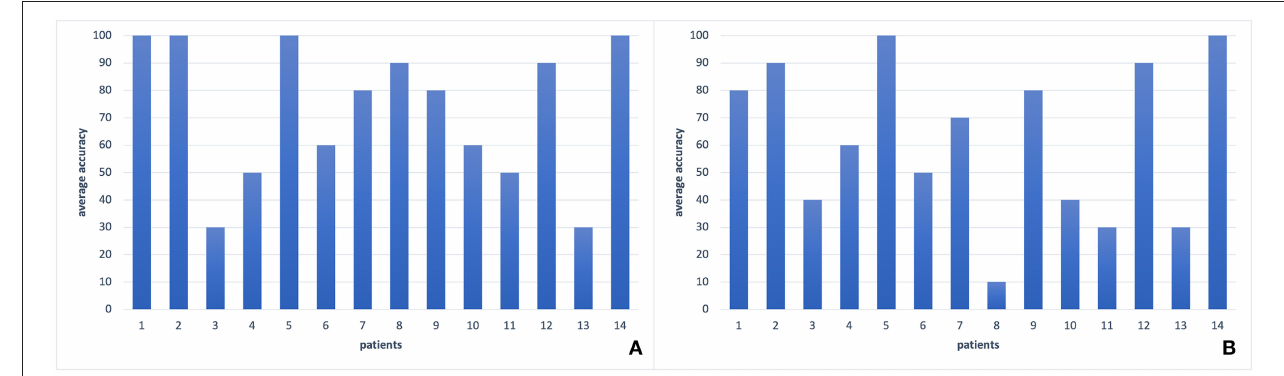
FIGURE 3 | Comparison of performances of leave-one-out validation for different window sizes for feature extraction process. (A) Results with window size length 1s, (B) Results with window size length 4s. The results with window size length 2s can be seen in Figure 5A . As it is seen in the Figure, 2-swindows give the best classification